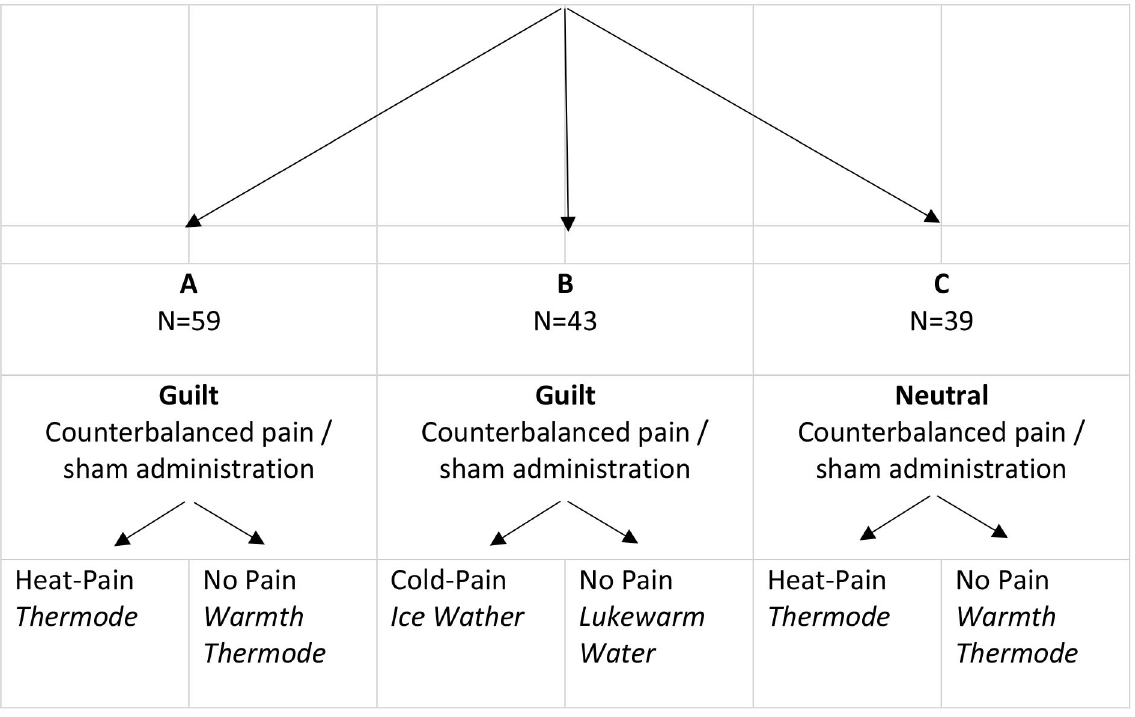
TABLE 1 Assignment to the experimental groups.